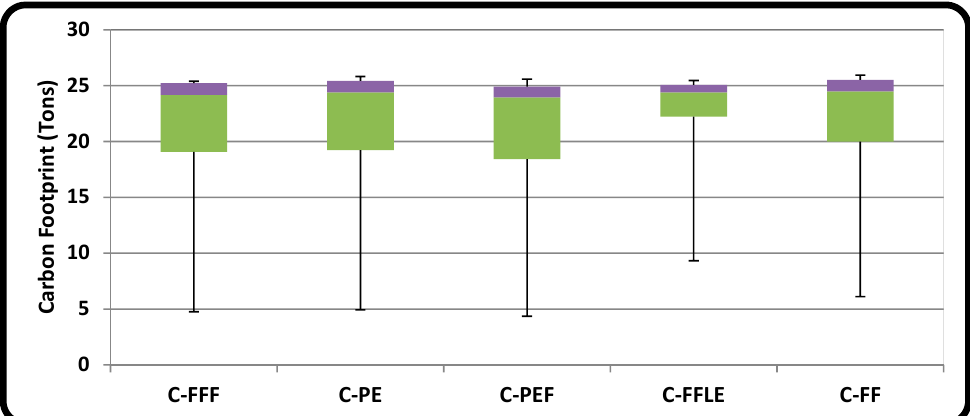
Figure 9. Carbon footprint.